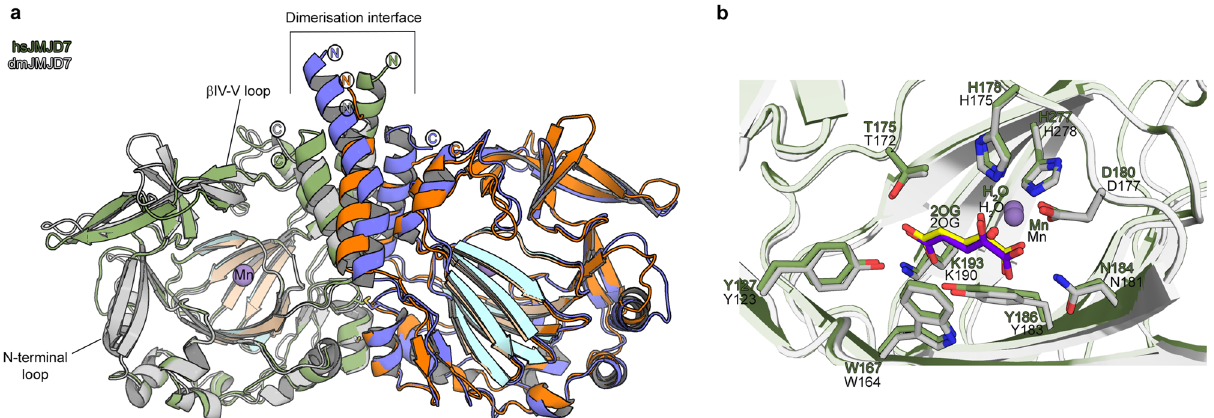
Figure 2. Comparison of the crystal structures of dmJMJD7 and hsJMJD7. ( A ) Except for the dimerization interfaces, the overall structures of dmJMJD7 and hsJMJD7 oxygenases adopt similar folds, despite only 45% sequence conservation. The core distorted DSBH fold is highlighted. ( B ) Views from the active sites of dmJMJD7 and hsJMJD7 showing very similar metal ion (Mn in place of Fe) coordination and co-substrate (2OG) binding